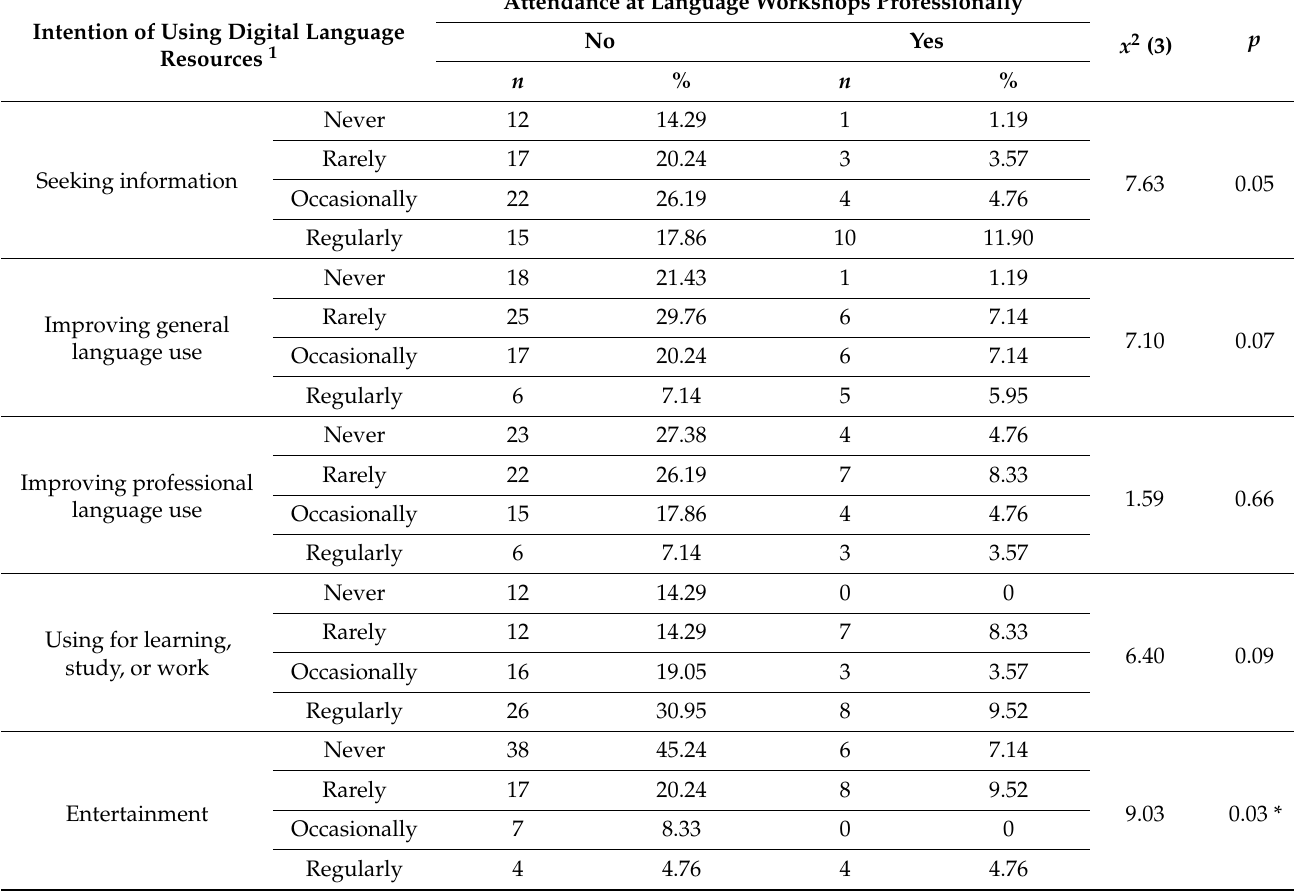
Table 1. A chi-square comparison table for participants’ professional attendance or non-attendance of language workshops with various types of